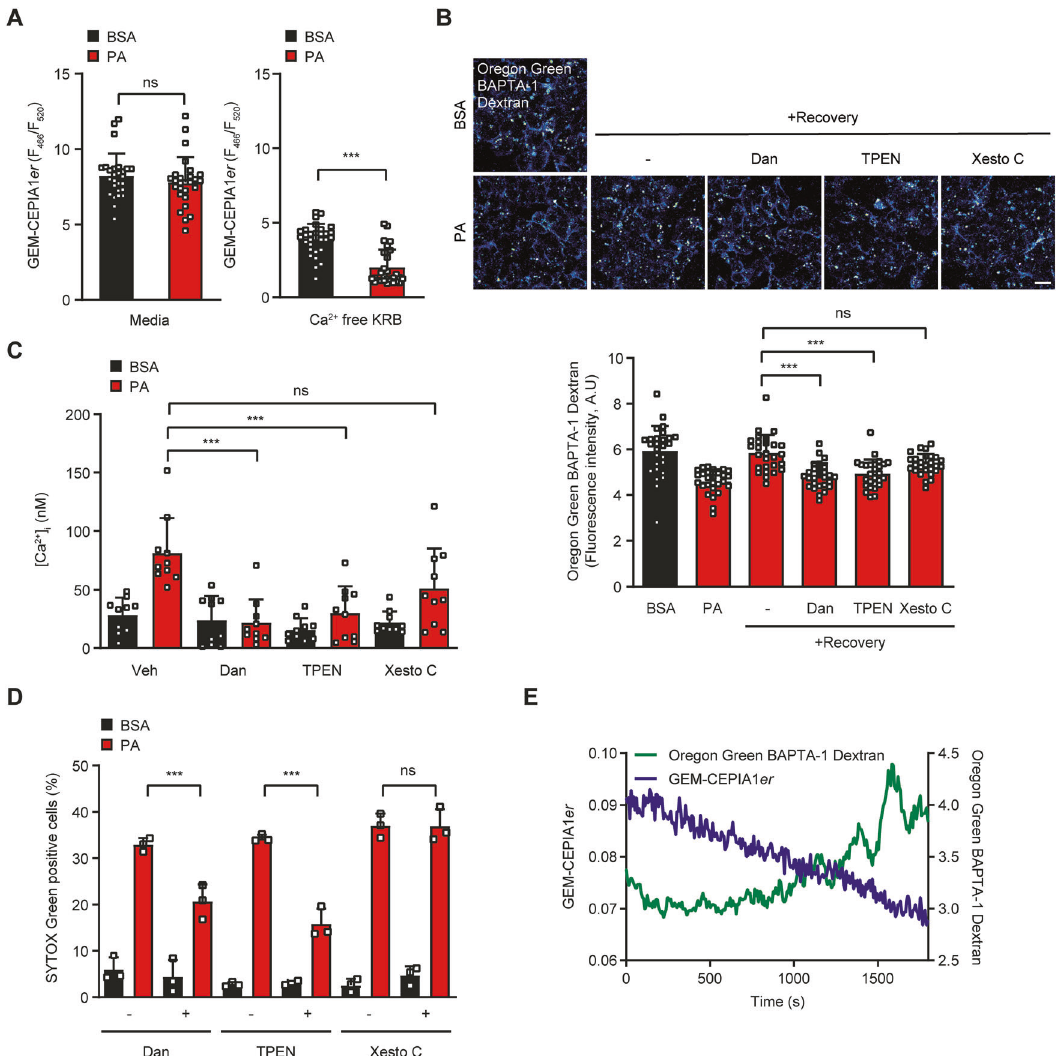
Fig. 3 Role of ER → lysosome Ca 2 + re fi lling in lipotoxicity. A After treatment of GEM-CEPIA1er -transfected HepG2 cells with PA for 6 h in a Ca 2 + -free KRBB (right) or a full medium (left), [Ca 2 + ] ER was determined by confocal microscopy. B After treatment of OGBD-labeled cells with PA for 6 h, cells were incubated in a fresh medium without PA in the presence or absence of 10 μ M dantrolene (Dan), 10 μ M TPEN or 3 μ M Xestospongin C (Xesto C). Recovery of [Ca 2 + ] Lys after removal of PA was determined by confocal microscopy (lower). Representative fl uorescence images are shown (upper). Scale bar, 20 μ m. C After the same treatment as in B, [Ca 2 + ] after Fura-2 loading. D After the same treatment as in ( B ), cell death was evaluated by SYTOX Green staining. E After treatment of GEM- CEPIA1er transfected cells loaded with OGBD with PA for 6 h and washout, recovery of [Ca 2 + ] simultaneously in the absence of extracellular Ca 2 + . Data are expressed as the means ± SD of three independent experiments. Statistical comparisons were performed using two-tailed Student ’ s t -test ( A ) or one-way ANOVA with Tukey ’ s multiple comparison test ( B – D ). (* P < 0.05; ** P < 0.01; *** P < 0.001; ns not signi fi